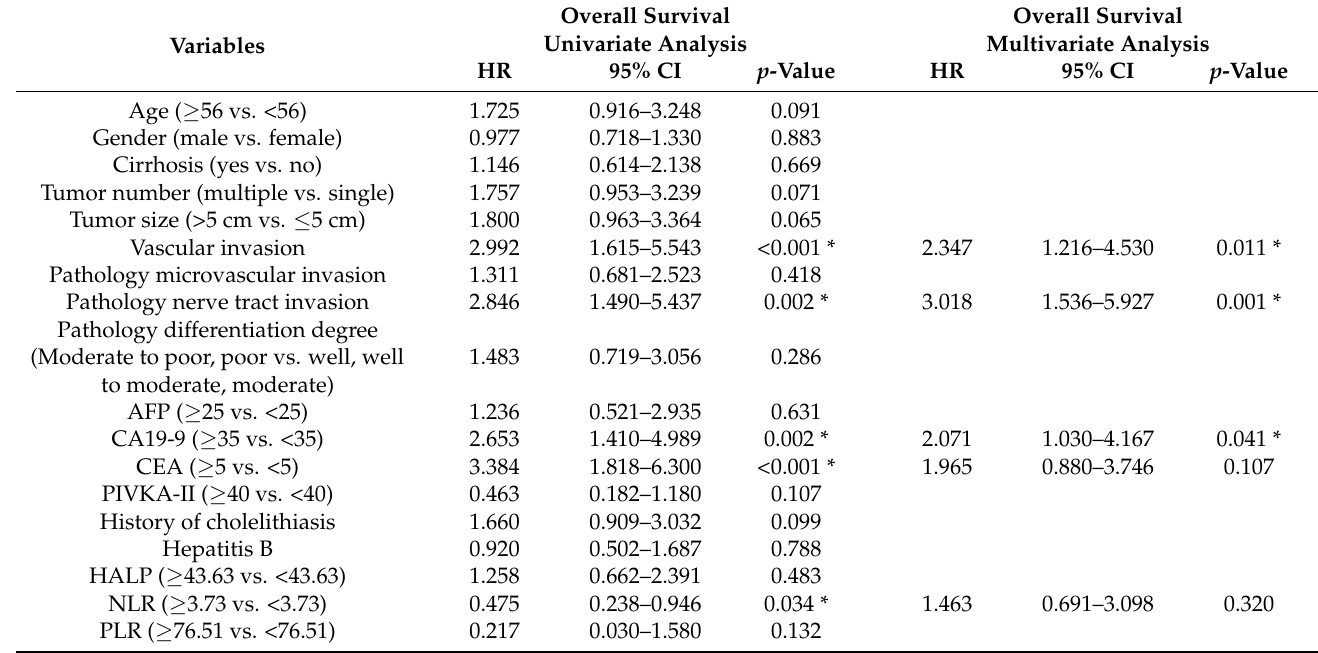
Table 2. Univariate and multivariate analysis for OS in patients with ICC.